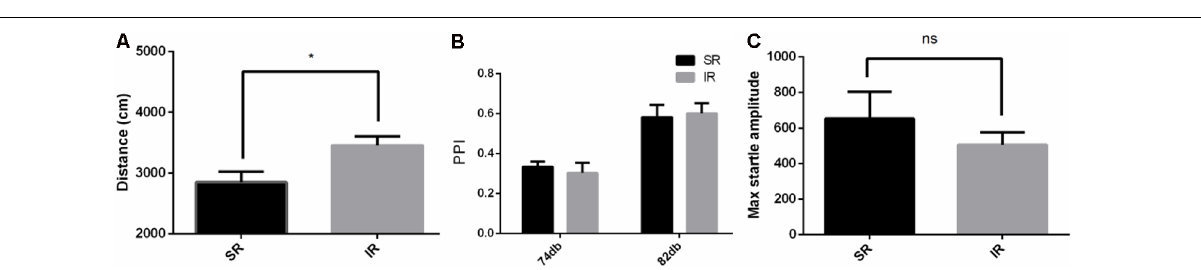
FIGURE 3 | Effects of isolation rearing on the behavior of the CX3CR1 − / − mice, including the total distance traveled (A) in the open field test, the PPI%, (B) in the acoustic startle response and the PPI test, and the pulse-alone amplitudes, (C) in the acoustic startle response and the PPI test. The results are expressed as the mean ± SEM ( n = 6 for the SR group and n = 6 for the IR group, * p < 0.05, ns p > 0.05, student’s t -test and two-way